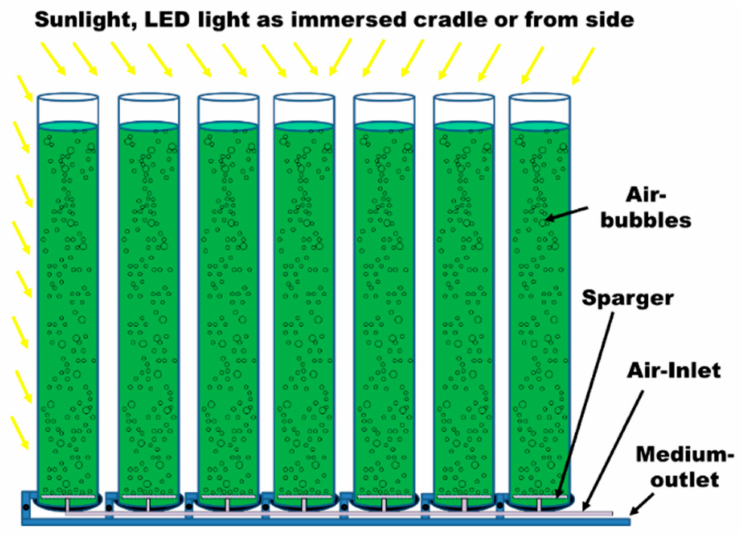
Figure 3. Schematic diagram showing vertical column photobioreactors suitable for outdoor and indoor